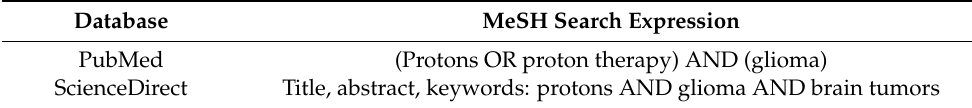
Table 1. MeSH expressions used on the two